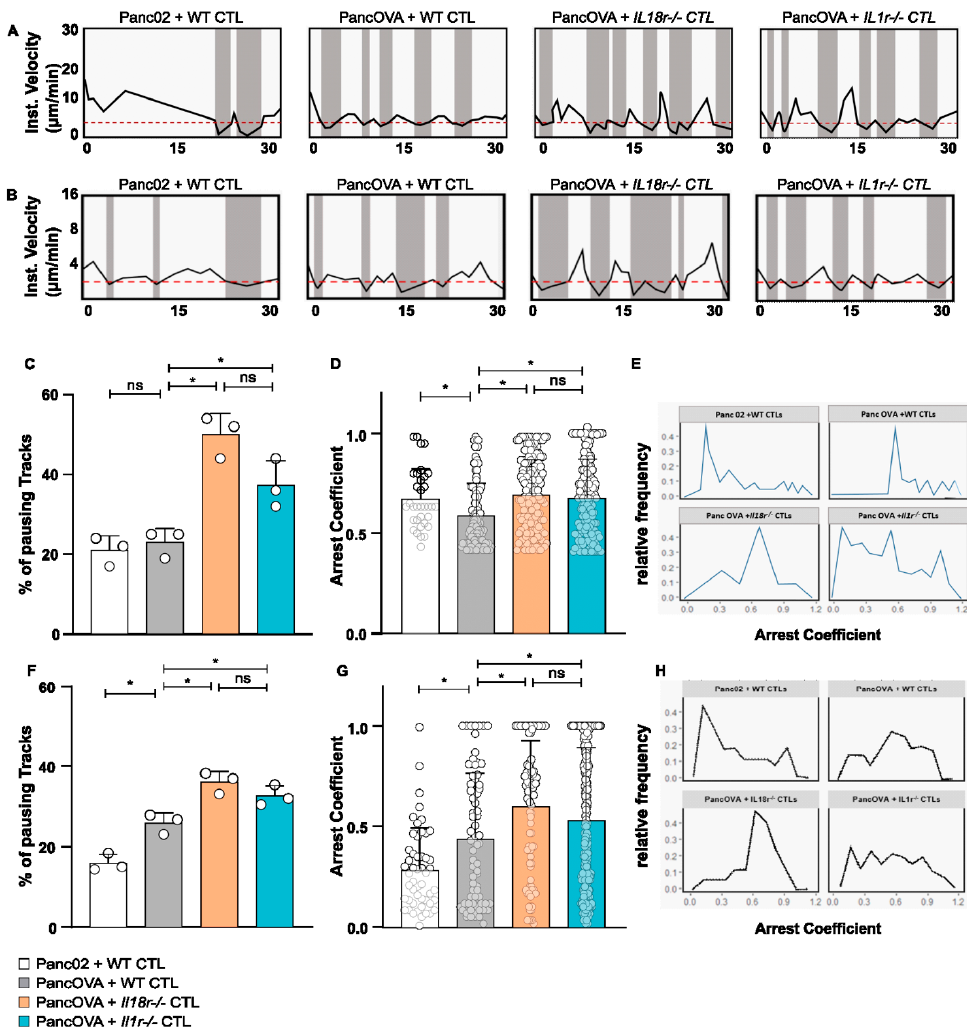
Figure 4. IL-18R signaling inhibits epitope-specific T-cell arrest on target cells in subcutaneous tumors and tumor spheroids . ( A ) Representative graph of the instantaneous velocity of individual tracked WT, Il1r − / − , and Il18r − / − CTLs in subcutaneous DSFC tumors. The graphs show the alteration of high and low instantaneous velocities. An instantaneous-velocity threshold of 4 μ m/min (dashed red line) was set to mark the pausing phases. ( B ) Representative graph of the instantaneous velocity of individual tracked WT, Il1r − / − , and Il18r − / − CTLs in co-culture with Panc02/PancOVA tumor sphe- roids. The graphs show the alteration of high and low instantaneous velocities. The threshold of instantaneous velocity (dashed red line) representing pausing phases had to be changed to 2 μ m/min, as CTLs in the Matrigel spheroids generally moved slower than T cells in the DSFC tumors. ( C ) Pausing phases of WT, Il1r − / − , and Il18r − / − CTLs in subcutaneous DSFC tumors as visualized by intravital MPM. The graph represents the percentage of CTLs moving with instantaneous velocity < 4 μ m/min. Individual dots represent the pooled data of 3 biological replicates. Statistical analysis was performed via an unpaired, two-tailed t -test; * p < 0.05. ns = not significant ( D ) The arrest coefficient of WT, Il1r − / − , and Il18r − / − CTLs in the subcutaneous tumor in the DSFC is depicted. The arrest coefficient is defined as the fraction of time during which an individual cell has instantaneous velocity < 4 µ m/min, which is indicative of an interaction with tumor cells. The graph represents pooled data from n = 3 biological replicates. Statistical analysis was performed with the Kolmogorov–Smirnov test; * p < 0.05. The arrest coefficient was calculated with R Studio. For visual clarity, only data points >0.4 are shown. ns = not significant ( E ) Relative frequency of arrest coefficient is depicted, representing pooled data from n = 3 biological replicates. Analysis was performed by calculating the arrest coefficient for different experimental groups (WT CTLs in Panc02 and